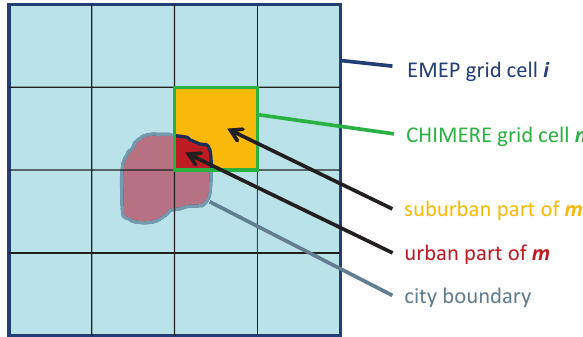
Fig. 4. Disaggregation of CHIMERE grid cell m into urban (red) and suburban (yellow)